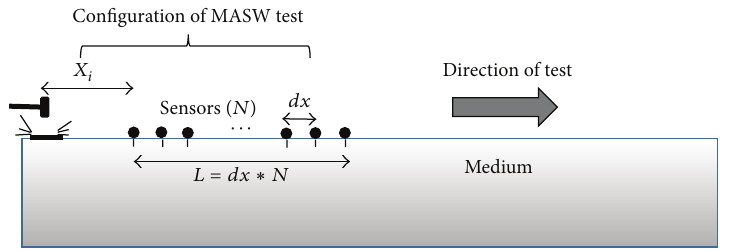
Figure 5: A scheme for an MASW test, in which 𝑋 𝑖 is the near offset, 𝑑𝑥 is the sensor spacing, and 𝐿 is the offset range.